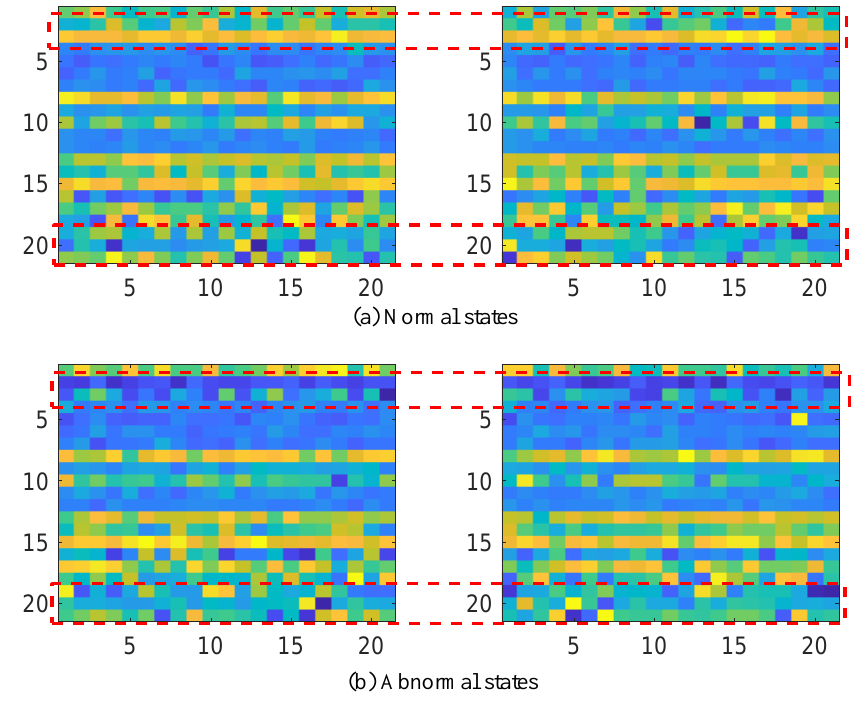
Figure 17. Comparison of normal and abnormal.